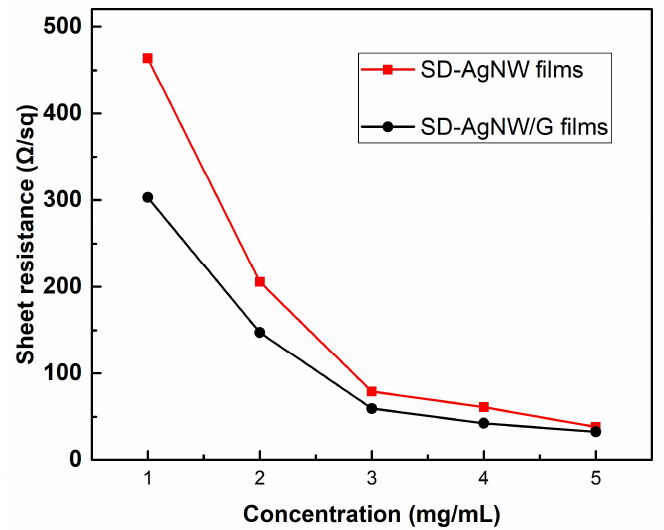
Figure 1. The sheet resistance of the SD-silver nanowire (AgNW) films with di ff erent concentrations.